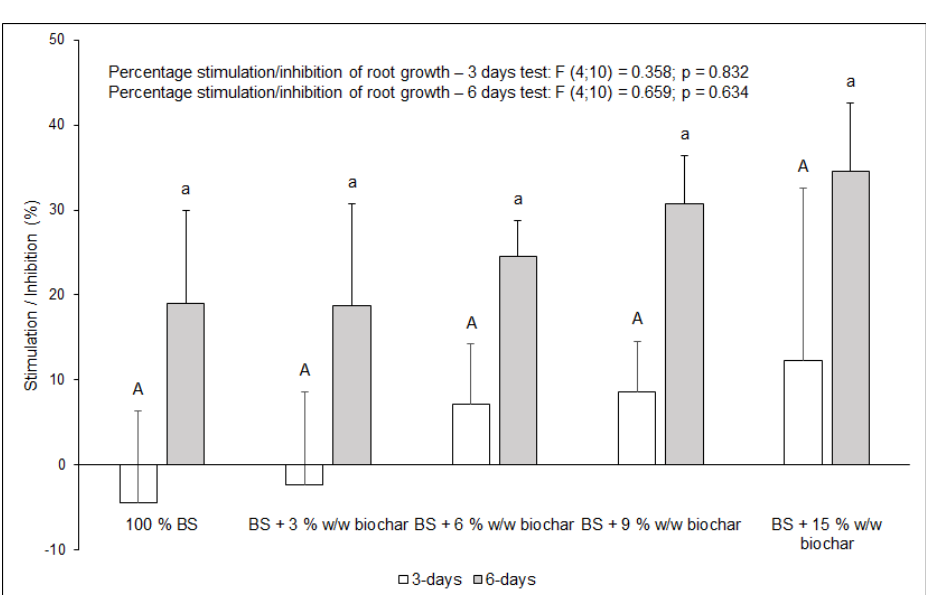
Figure 9. Comparison of inhibition/stimulation of root growth of Lepidium Sativum L. after 3 and 6 days of exposure to burnt soil supplemented with biochar in increasing proportions (compared to OECD soil). Average values (n = 3) + SE are presented, different uppercase letters indicate significant differences between individual variants after 3 days of testing and small letters after 6 days (one-way ANOVA with post hoc Tukey’s HSD test). The results of the F test are shown at the top of the graph. Table 7. Comparison of all means of stimulation/inhibition of root growth of Lepidium sativum L. after 3 and 6 days of exposure to burnt soil supplemented with compost or biochar in increasing proportions (compared to burnt soil). Treatment